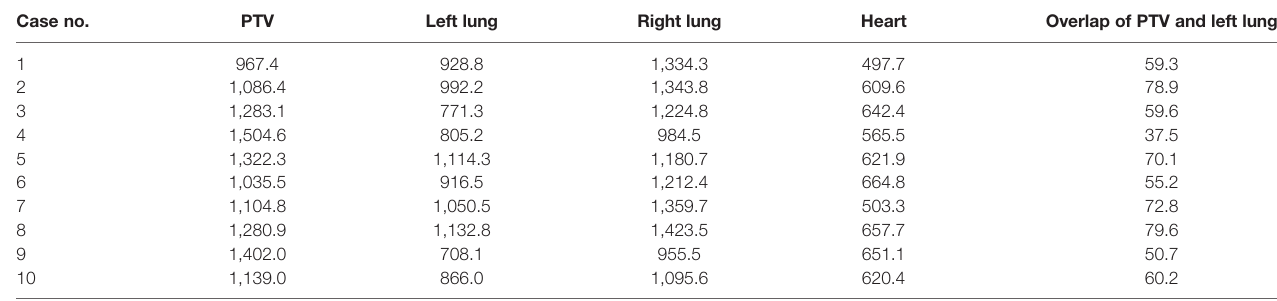
TABLE 1 | Structure volumes of left-sided PMRT